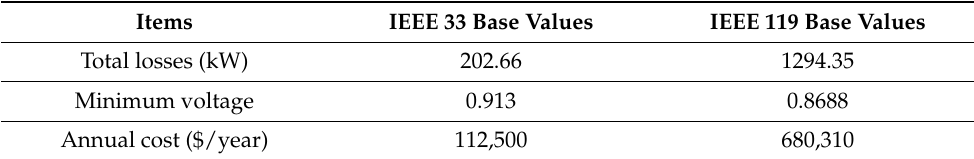
Table 1. The base data of the systems under study.